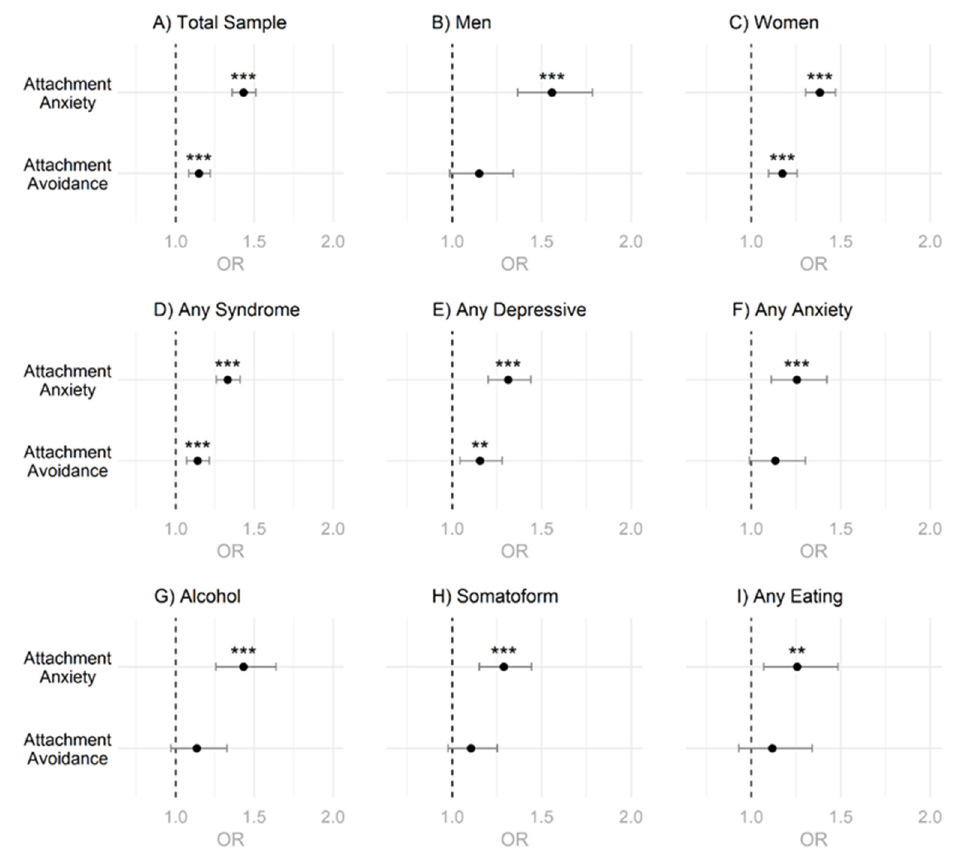
Figure 5. Odds Ratios for Attachment Dimensions and the Intention to Start Psychotherapy. ( A ) Analysis for Total Sample. ( B ) Analysis for Men. ( C ) Analysis for Women. ( D – I ) Analysis for Specific Syndromic Groups. Note. OR = Odds Ratio. p -values were adjusted for multiple testing using the Holm–Bonferroni method. ** = p < 0.01, *** = p < 0.001.